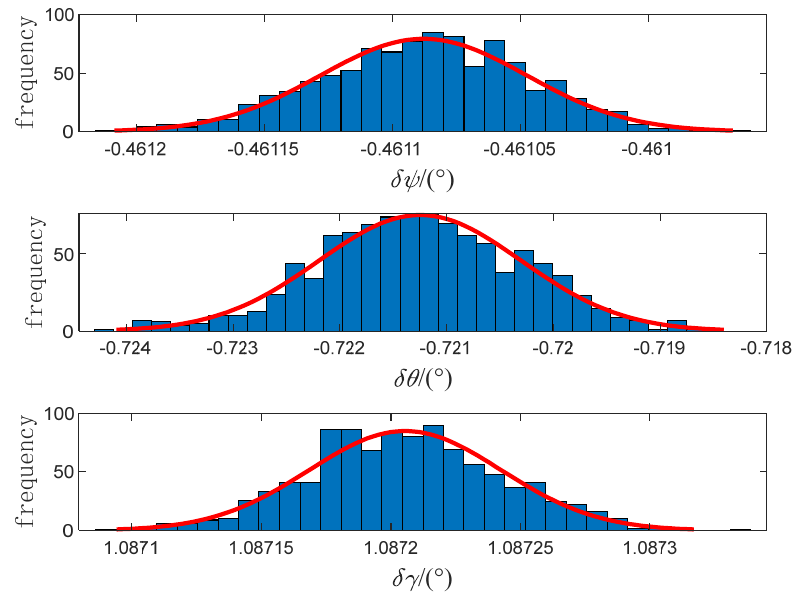
Figure 11. Monte Carlo attitude results of Torus-OPNAV.